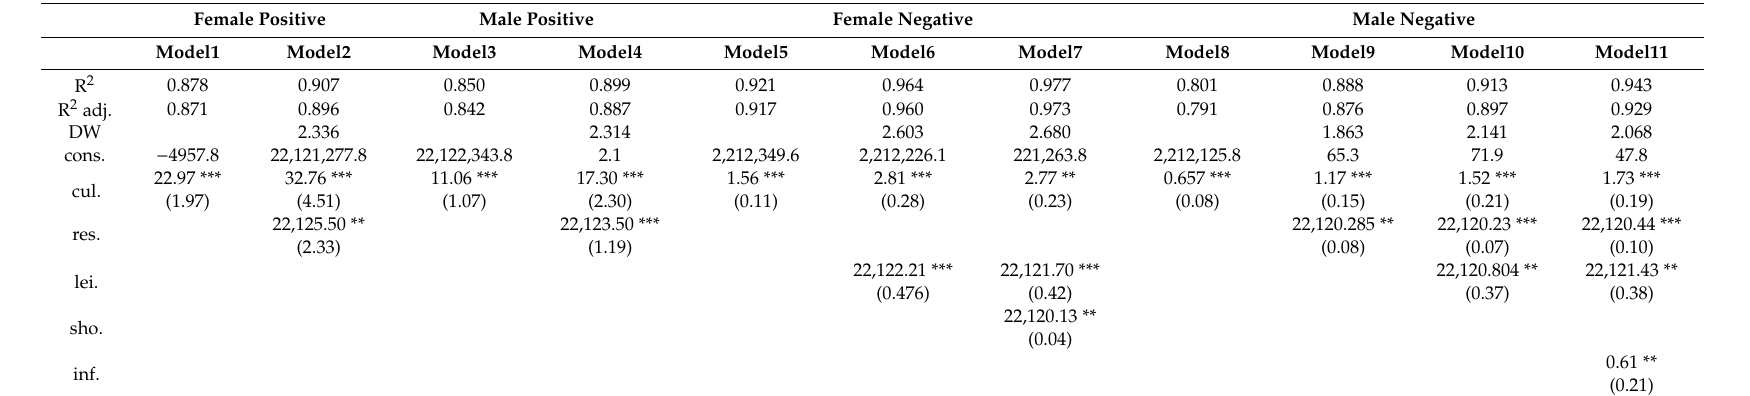
Table 6. Multiple linear regression parameter